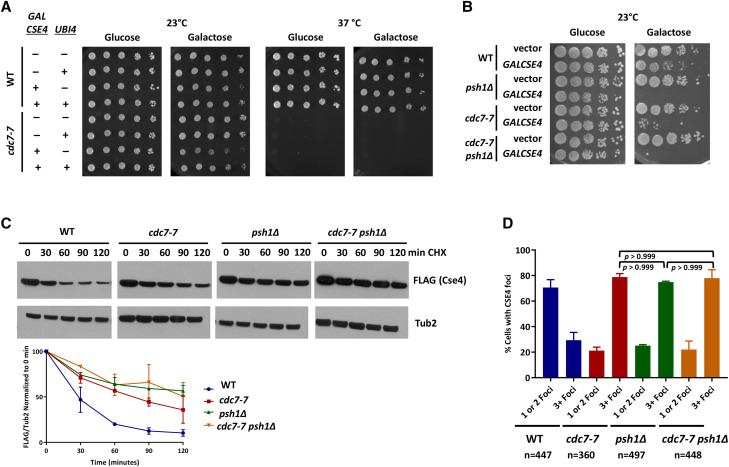
Cdc7 regulates Psh1-mediated proteolysis of Cse4. A. Overexpression of UBI4 suppresses the SDL of a cdc7-7 GALCSE4 strain. Growth assays of wild type (RSY299) and cdc7-7 (RSY302) cells transformed with empty vector (pMB433, GALCSE4 -) or GAL-HA-CSE4 (pMB1597, GALCSE4+) and subsequently transformed with empty (pRS425, 2µ UBI4-) or UBI4 (pMB1604, UBI4+). Cells were spotted in fivefold serial dilutions on media selective for the plasmids containing either glucose (2%) or raffinose/galactose (2% each) and incubated at 23° or 37° as indicated for 3-5 days. Three independent transformants for each strain were assayed and the representative image is shown. B. The GALCSE4 SDL phenotype of the cdc7-7 psh1∆ strain is similar to that observed for psh1∆ and cdc7-7 strains. Growth assays of wild type, psh1∆, cdc7-7, and cdc7-7 psh1∆ strains with endogenously expressed Flag-Cse4 (vector; YMB10043, YMB10126, YMB10040, and YMB10124, respectively) or Flag-Cse4 expressed from a galactose-inducible promoter integrated into the genome (GALCSE4; YMB10044, YMB10127, YMB10041, and YMB10125, respectively) spotted in fivefold serial dilutions on to rich media containing either glucose (2%) or raffinose/galactose (2% each) and incubated at 23°C for 5 days. Three independent transformants for each strain were assayed and the representative image is shown. C. The Cse4 proteolysis defect in a cdc7-7 psh1∆ double mutant is similar to that observed for a psh1∆ strain. Western blot analysis of protein extracts from wild type (YMB10044), cdc7-7 (YMB10041), psh1∆ (YMB10127), and cdc7-7 psh1∆ (YMB10125) strains grown to logarithmic phase of growth in raffinose-containing media (2%). Expression of GAL-FLAG-CSE4 was induced with galactose (2%) for 1.75 hr. Cells were then treated with cycloheximide (CHX, 10 µg/ml) and glucose (2%). Aliquots were taken at the indicated timepoints. Protein extracts were analyzed using Western blot analysis and blots were probed with anti-FLAG (Cse4) and anti-Tub2 (loading control). The graph shows the quantification of the levels of FLAG-Cse4 remaining after treatment with CHX relative to Tub2 from two independent experiments. Error bars represent SEM. D. Mislocalization of Cse4 is not further enhanced in the cdc7-7 psh1∆ strain. Localization of Cse4 was examined using chromosome spreads prepared from nocodazole arrested wild type (YMB10044), cdc7-7 (YMB10041), psh1∆ (YMB10127), and cdc7-7 psh1∆ (YMB10125) strains. FLAG-Cse4 was labeled with Cy3 and DNA with DAPI. The graph displays quantification of Cse4 localization as a percentage over total cell count. The graph displays the SEM of two independent experiments, psh1Δ 3+ foci vs.
cdc7-7 3+ Foci, cdc7-7 3+ foci vs.
cdc7-7 psh1Δ 3+ Foci, and psh1Δ 3+ foci vs.
cdc7-7 psh1Δ 3+ Foci p-value > 0.999.